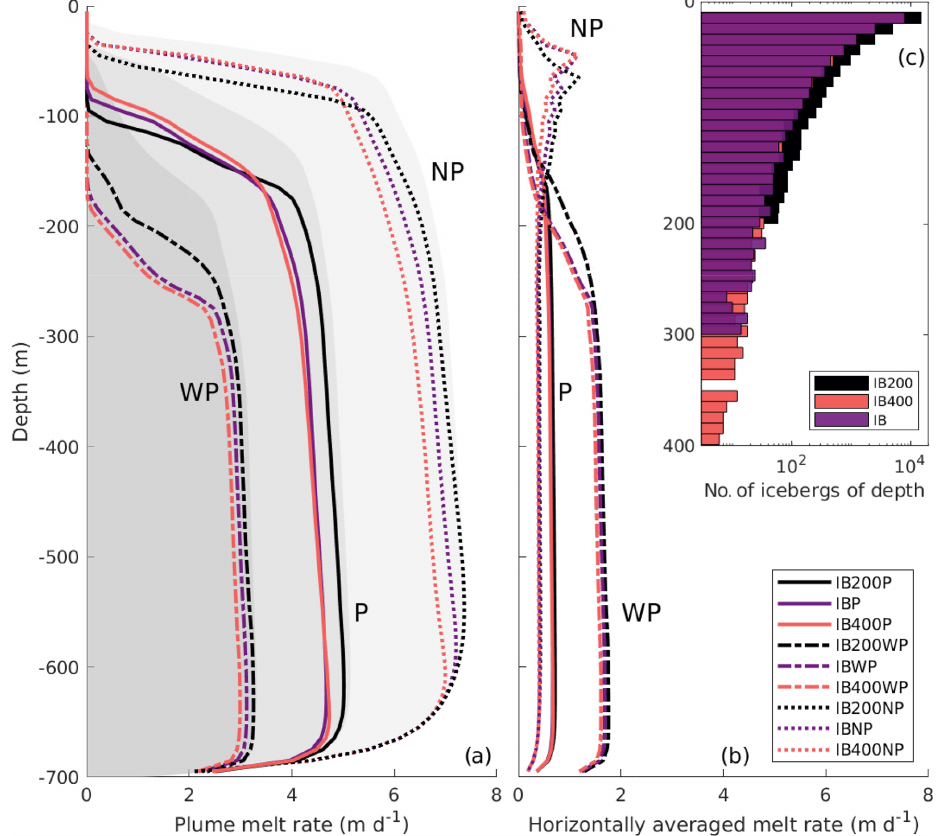
Figure 10. August vertical melt rate profiles for (a) plume melt and (b) horizontally averaged frontal melt for the nine iceberg experiments with three different iceberg distributions (colours; see panel (c) for colour labels) and wide (WP), default (P) and narrow plumes (NP) (semi- dashed, solid and dotted lines, respectively). See Table 1 for experiment naming. The three different grey shades in panel (a) indicate the vertical melt rate profile of each of the three plumes without icebergs. Panel (c) shows the number of icebergs extending to a certain depth at 10m intervals in the three used iceberg distributions.